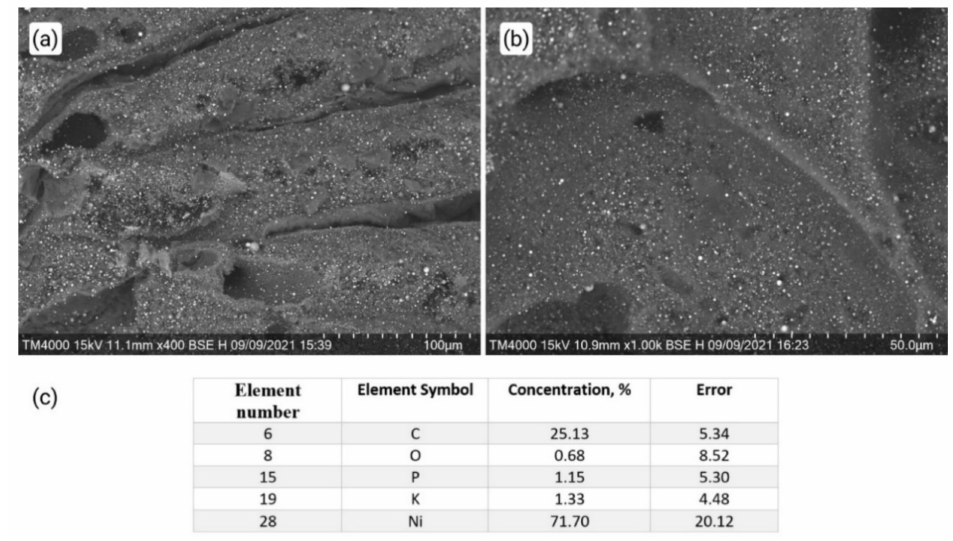
Figure 3. SEM images ( a , b ) and elemental analysis from energy dispersive X-ray spectrometry ( c ) for an object 3D-printed from the photopolymer composition with concentration of ZIF-8 and Ni-BTC 5 wt.% and 5 wt.%, respectively. Traces of potassium may result from its leaching from the glassware during the synthesis of Ni-BTC.